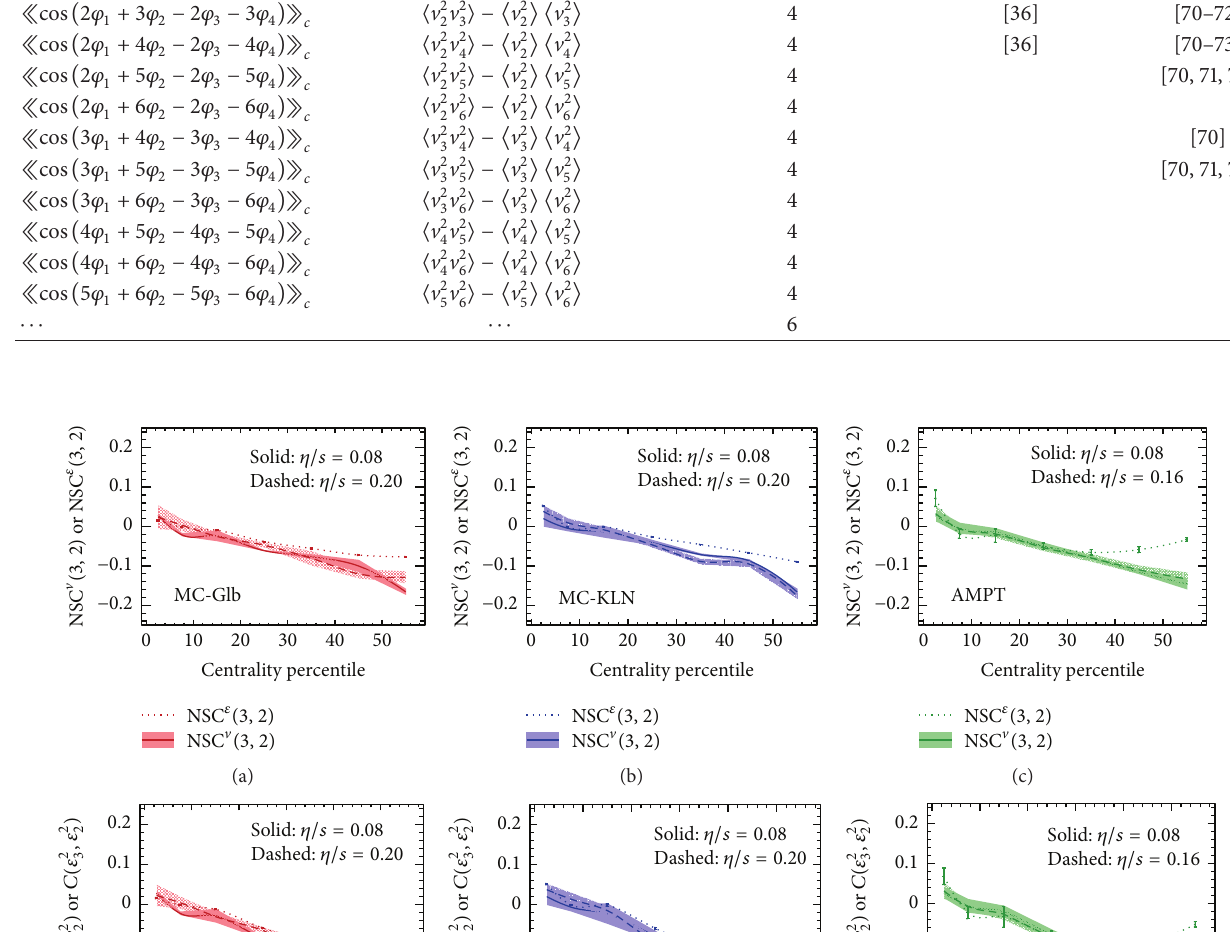
Table 1: List of observables for correlations of flow harmonics, including all combinations of symmetric 2-harmonic 4-particle cumulants (up to V 6 ). Observables